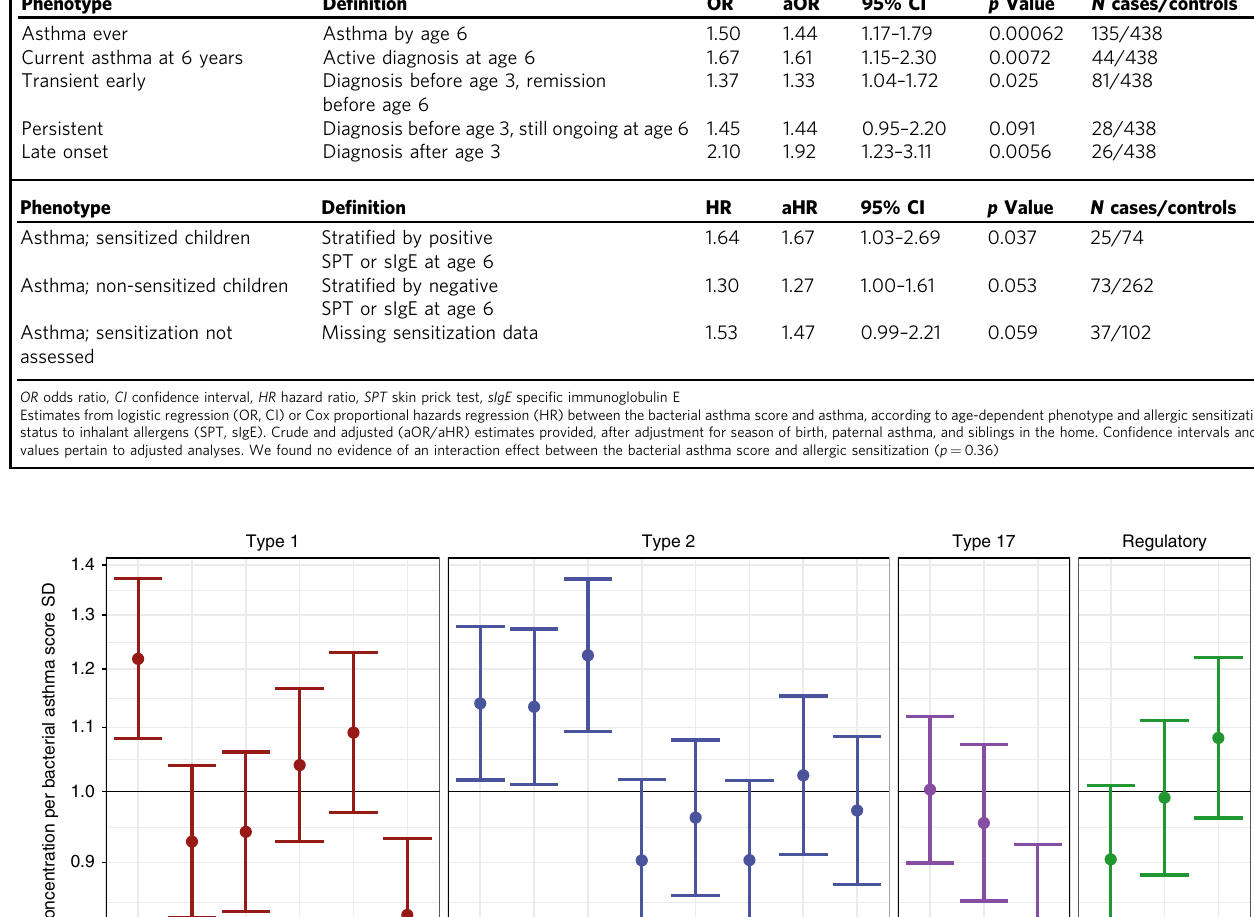
Table 2 Microbiota – asthma association according to age at onset, persistence, and sensitization status